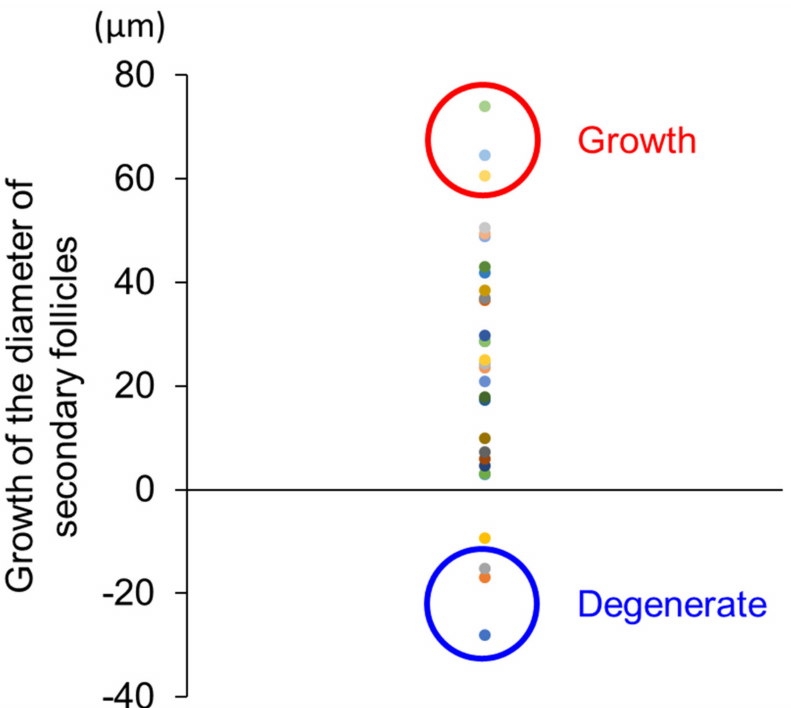
Figure 4. Distribution of the growth of the diameter of secondary follicles during culture. Growth of secondary follicles was expressed as the difference in the diameter of each follicle on days 0 and 6. Samples selected as the growth group were marked by a red circle, while samples selected as the degenerate group were marked by a blue